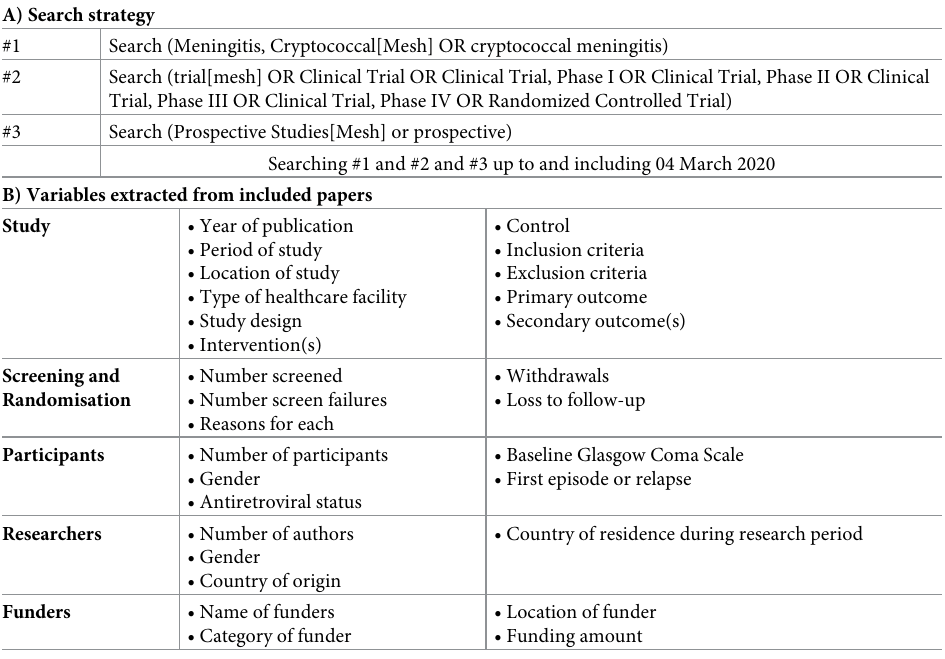
Table 1. (A) The search strategy. (B) A summary of the variables extracted from included